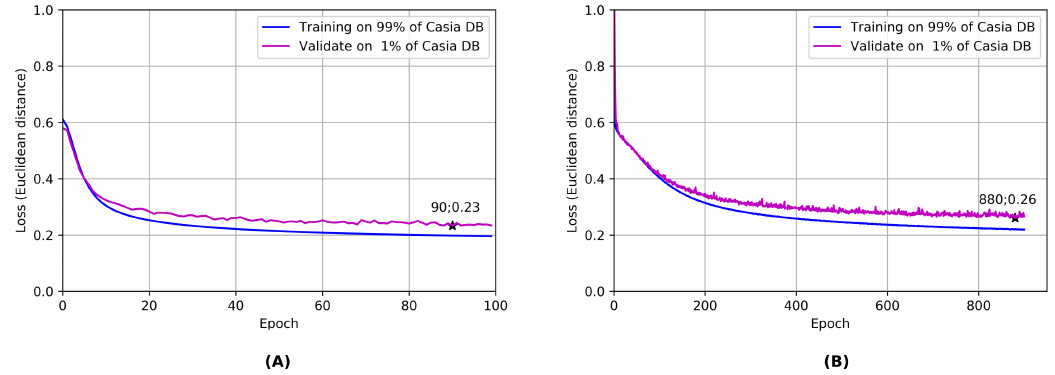
Figure 16. Two distillation trainings are compared: in panel ( A ), the ’full’ learning is exploited, providing the best results. In panel ( B ), a different strategy is used: for each training batch a different identity is extracted and only two random images are given to the network. This procedure is way faster than the previous one (1000 epochs in 6–8 hours vs 100 epochs in 15 hours) but obviously a bit less performing. During the distillation, what counts is the number of identities (cluster centroid), rather than the number of samples for each